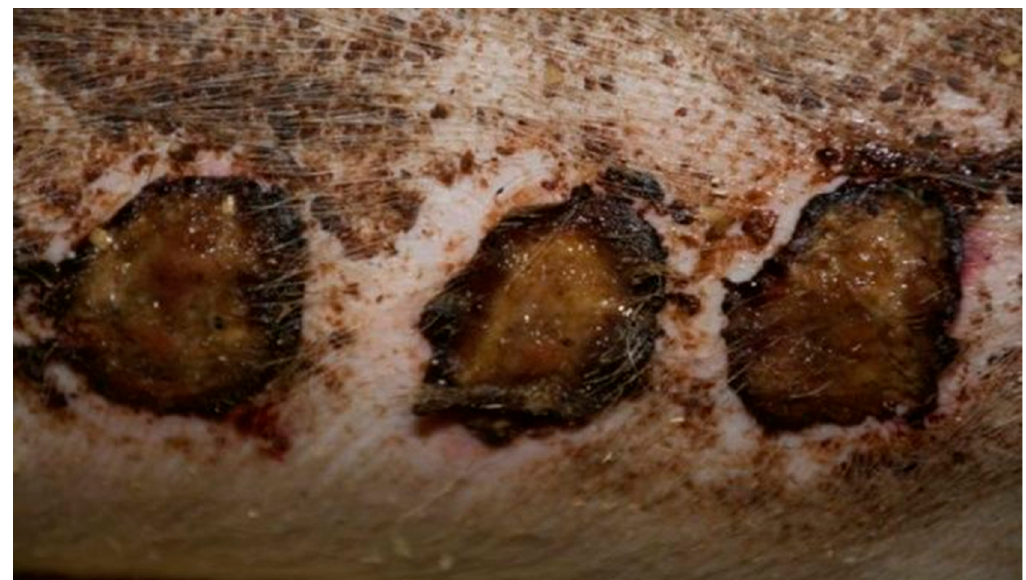
Figure 7. Group D3—burn wound treated with the ointment with 1% propolis and 1% nanosilver on day 15.